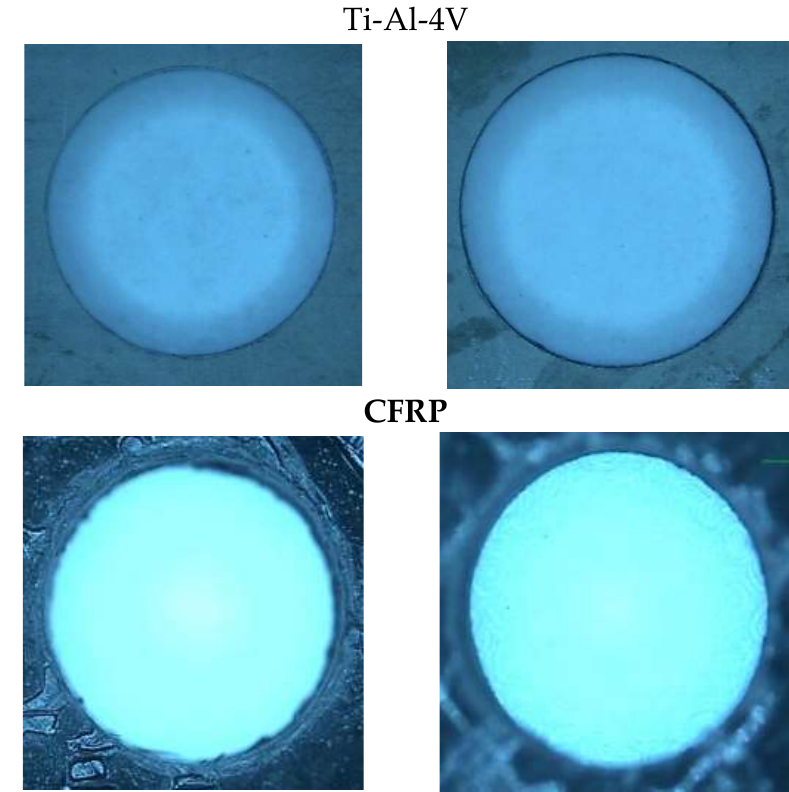
Figure 17. Hole interface after helical